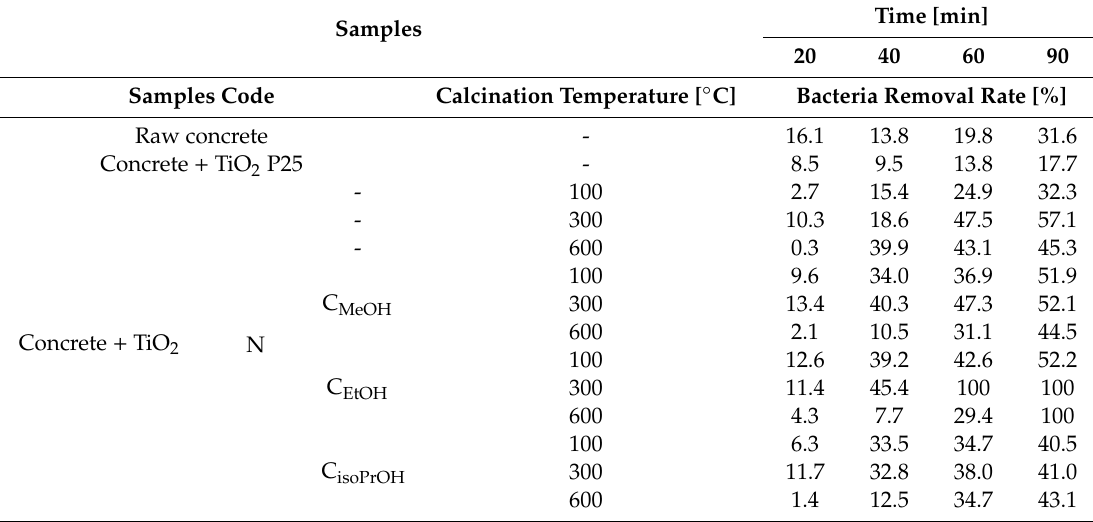
Table 2. The reduction [%] of initial bacteria cells number in the